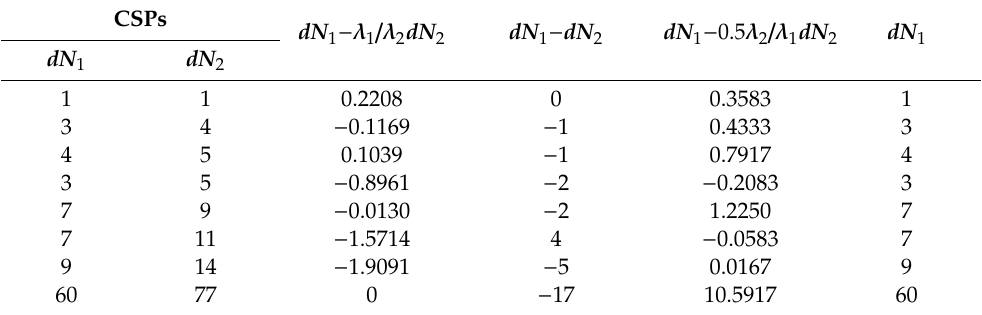
time-di ff erence geometry-free (STG)